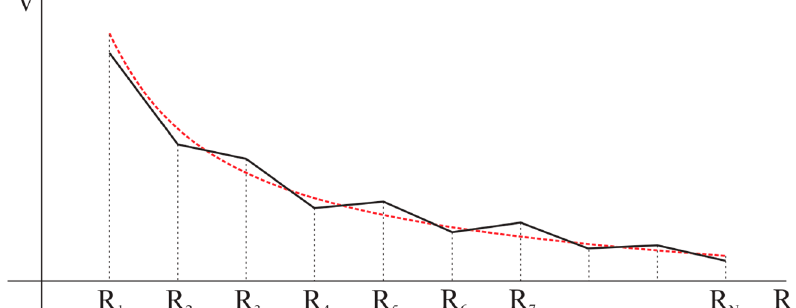
Figure 2. Graphic view of the polygonal line, N ‐ 1 of the trapezoid and curve v = K ∙ R − n .